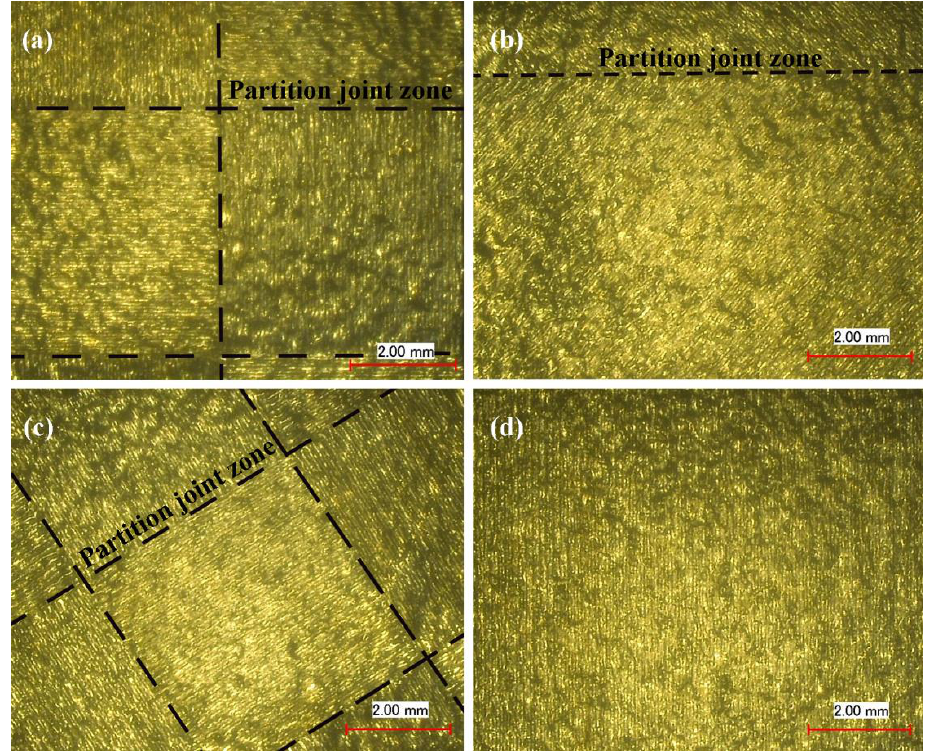
Figure 6. The surface morphology of samples (magnification 20×): ( a ) Normal partition strategy; ( b ) Oblique line and layer-staggered divisional strategy; ( c ) Spiral divisional strategy; ( d ) “ s ” style orthogonal scanning strategy.